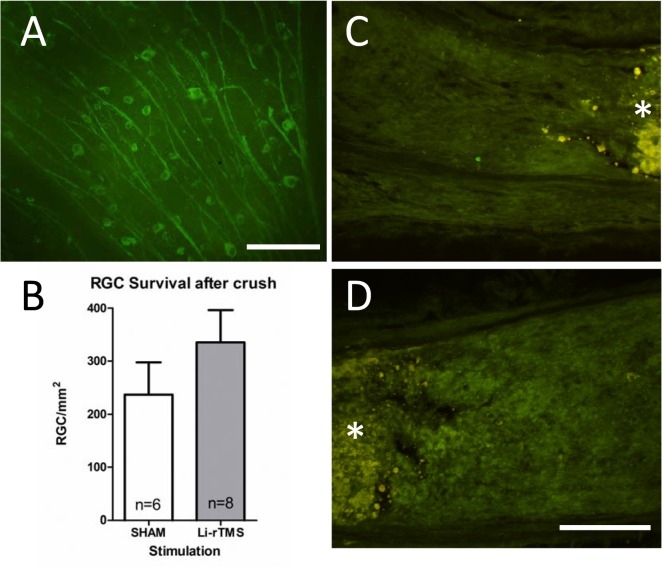
LI-rTMS does not affect RGC survival or axonal regeneration following optic nerve crush.A: photomicrograph showing RGCs immunolabelled with β3 tubulin following an optic nerve crush and 2 weeks of daily LI-rTMS. Scale bar is 100 μm. B: Histogram showing counts of surviving RGCs in LI-rTMS and sham stimulated retinas 2 weeks following an optic nerve crush. There was no significant difference between the stimulation groups (p = 0.256). Error bars are standard error of the mean. C, D: GAP-43 immunohistochemistry in the proximal (C) and distal (D) optic nerve did not result in labelling of any axons. The crush site is indicated by *. Scale bar 100 μm